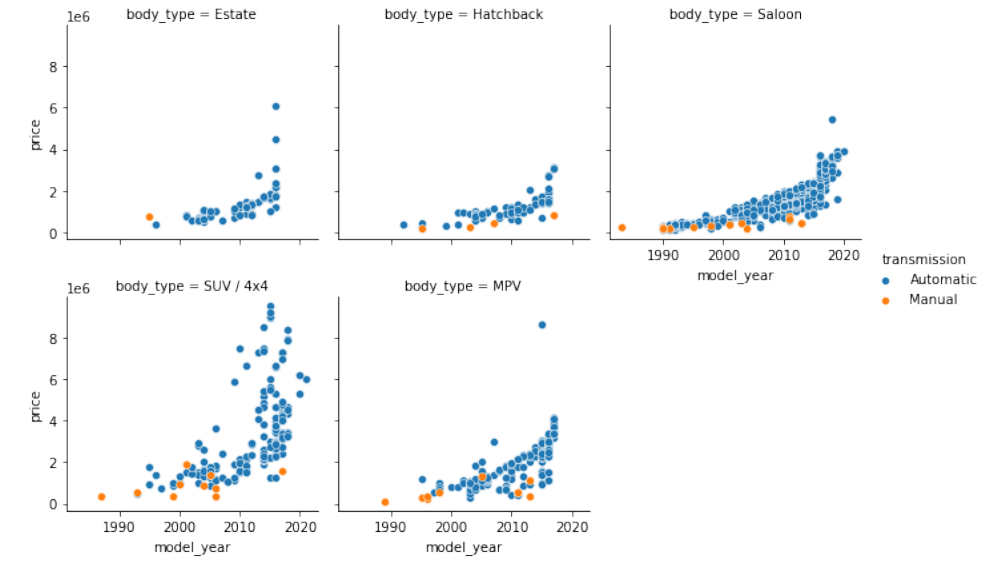
Figure 7. Facet grid for different body_type features against model_year